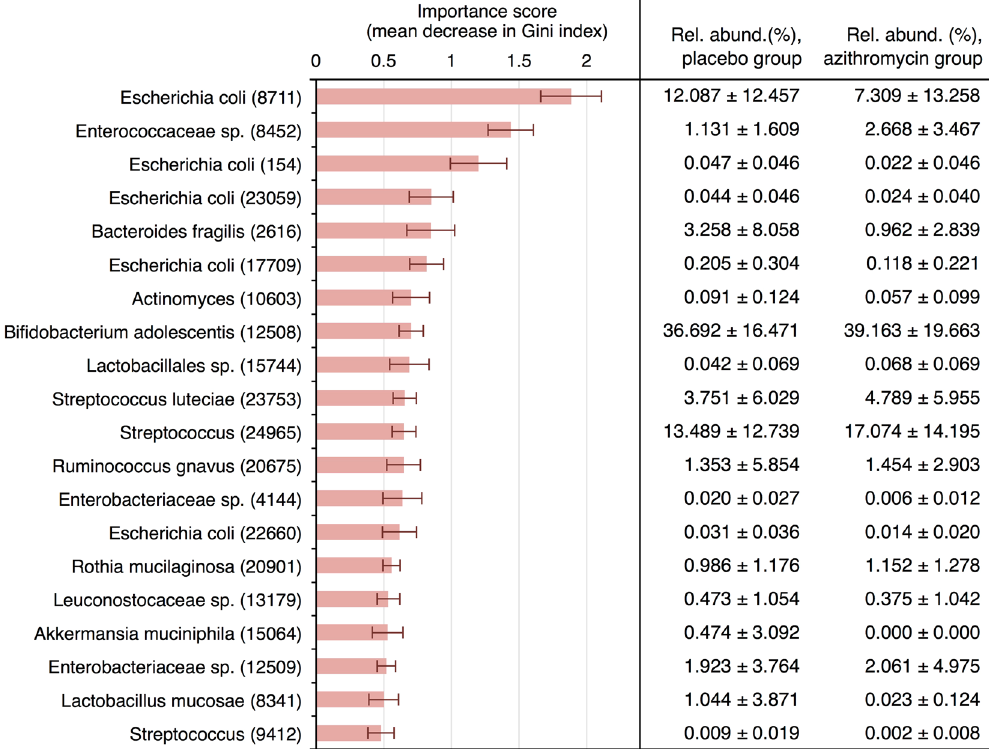
Figure 3. Highest ranking taxa by Random Forest importance score for prediction of study arm after treatment with azithromycin. Importance scores were calculated based on the decrease in Gini impurity index associated with inclusion of each variable in a tree. Mean importance scores ( ± standard deviation) were calculated across 200 cross-validation iterations of the Random Forests algorithm, with 5,000 trees per